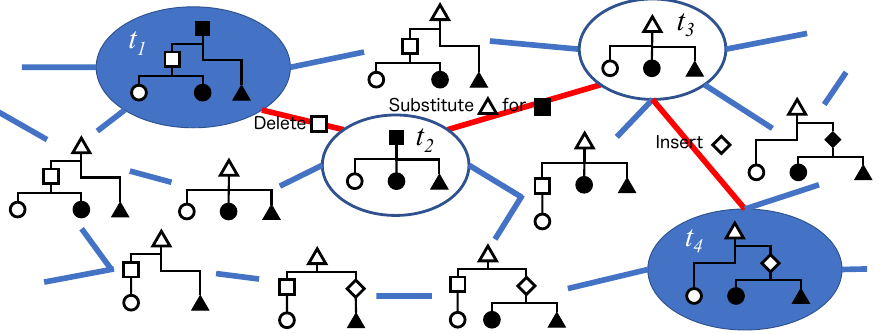
Figure A2. Taï distance between t 1 and t 4 is